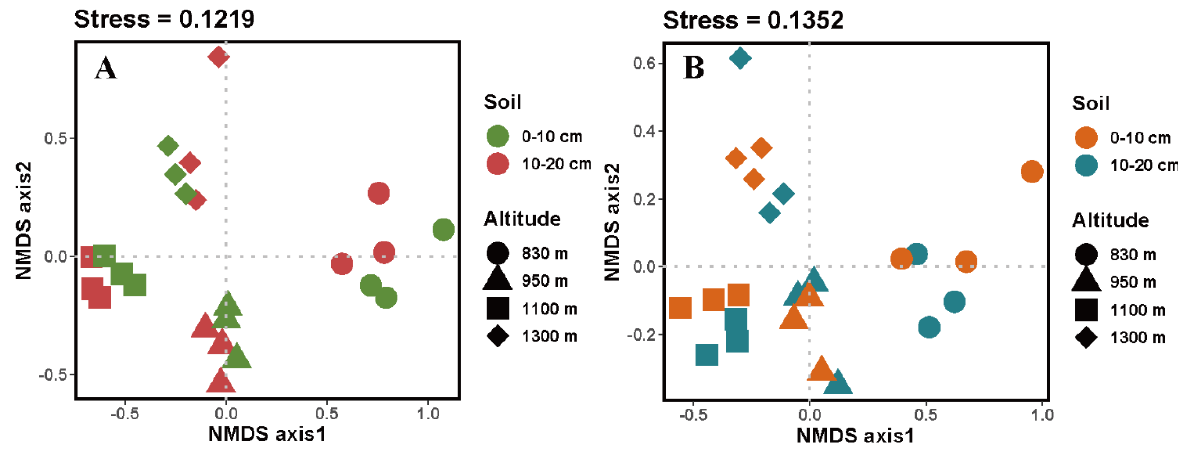
Figure 3. Nonmetric multidimensional scaling ordinations showing EcM (A) and SAP (B) fungal communities using the Bray–Curtis dissimilarity distance based on OTUs. Numbers after “Altitude” and “Soil depth” are R 2 , indicating the variation in EcM and SAP fungal community composition that can be explained by altitude or soil depth, detected using PERMANOVA.